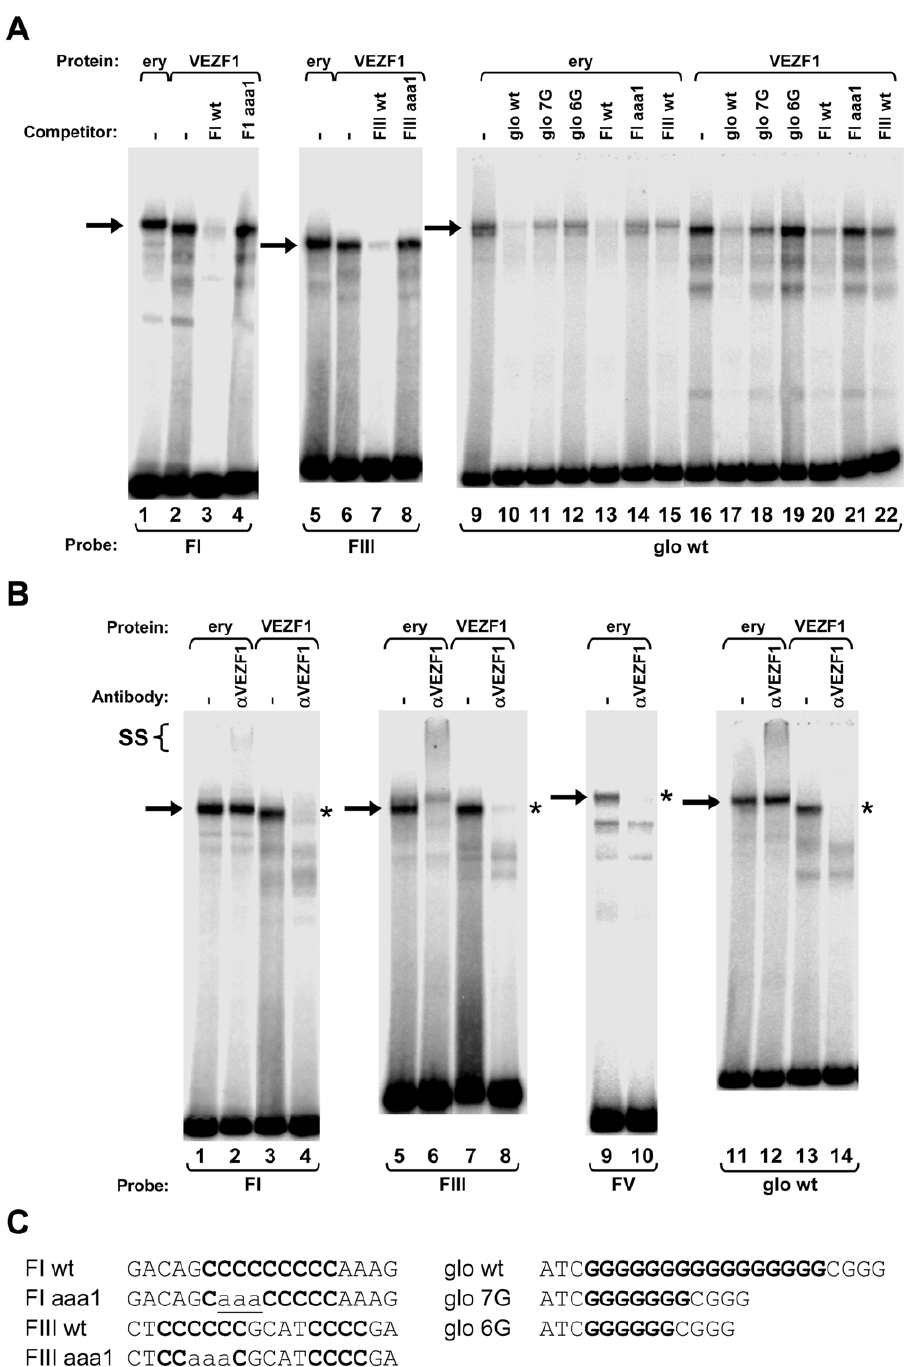
Figure 6. VEZF1 specifically interacts with dG–dC strings within HS4 footprints I and III and the b A -globin promoter. (A) Gel mobility shift analysis of interactions with 32 P-labelled HS4 FI, and FIII, or b A -globin promoter ‘glo wt’ oligonucleotide duplexes. Unlabelled competitor duplexes (indicated above each lane) were added at 50 fold molar excess. Adult chicken erythrocyte nuclear extract (ery) or recombinant chicken VEZF1 were used as indicated by brackets above the lanes. Arrows indicate footprint sequence-specific complexes. (B) Gel mobility supershift assays using 32 P-labelled FI, FIII, FV, and glo wt oligonucleotide duplexes. Proteins were pre-incubated with anti-VEZF1 antibodies (indicated above each lane) prior to incubation with DNA. VEZF1 supershifts are evidenced by either abrogation of specific complexes (asterisks) and/or formation of low mobility ternary complexes (SS). Antibodies alone do not give rise to complexes with any of the duplexes used (data not shown). Supershift experiments shown are cropped from the full gels shown in Figure S3. (C) Sequences present in oligonucleotides used in gel mobility shift assays. dG–dC strings and their mutations are bold and underlined, respectively.